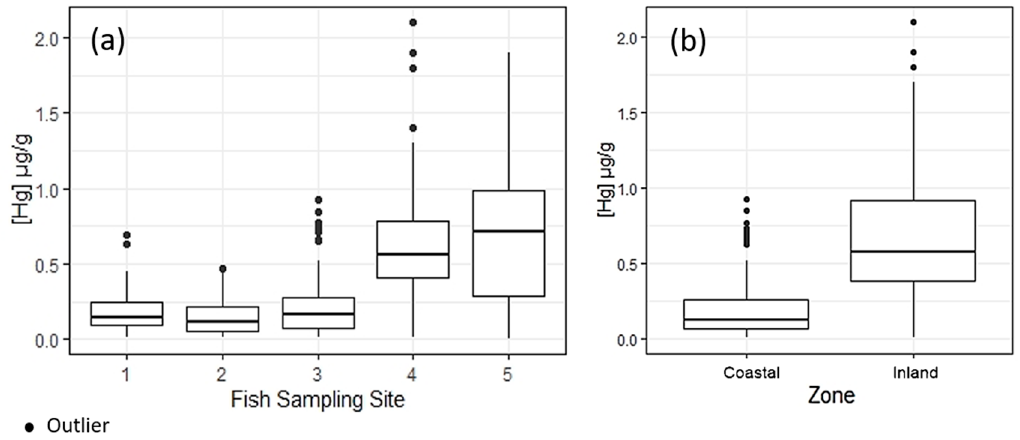
Figure 4. Distribution of mercury concentrations in fish (µg/g) in ( a ) the sampling sites and ( b ) the aggregated zones (Kruskal–Wallis: 95% CI, p < 0.001).